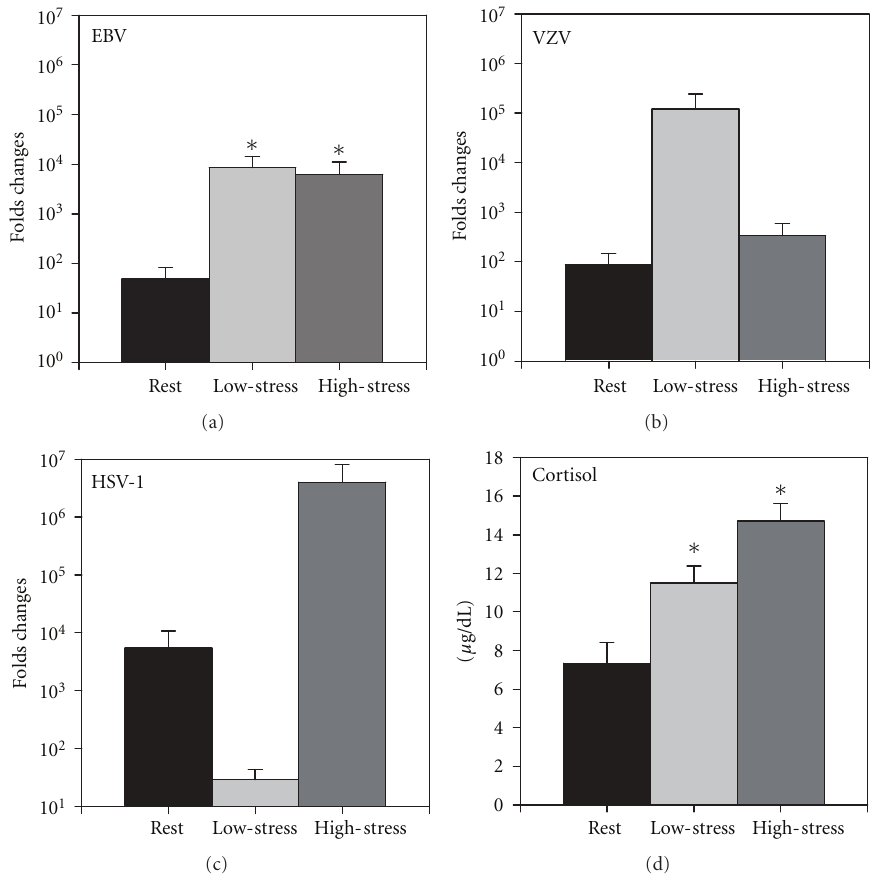
Figure 2: Dynamics of the 3 types herpes virus DNA levels (a–c) and cortisol concentration (d) in saliva of the subjects. Data presented as Mean ± SEM, n = 12. ∗ Statistically significant ( P < 0 . 05) di ff erence. RQ: relative quantification of SYBR Green